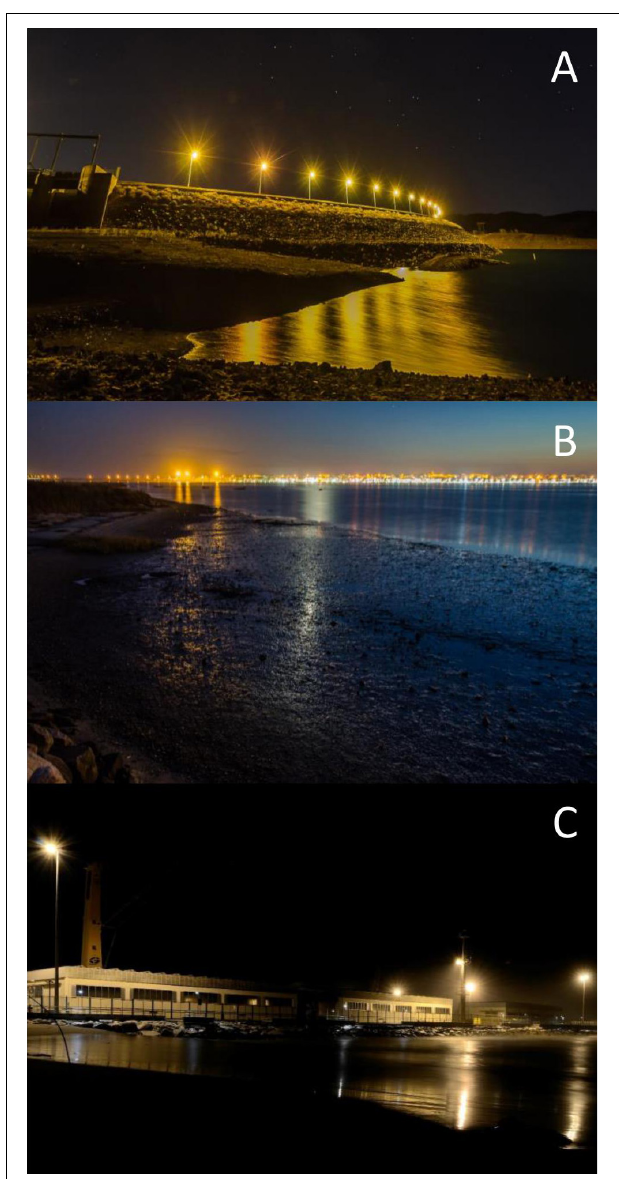
FIGURE 1 | Night light pollution caused by sources of artificial light located close (water damn, A ) or relatively far away (intertidal estuarine mudflat, B ), from water bodies and adjacent areas. (C) Example of alternating low and high intensity areas, along an artificial structure illuminated by streetlamps within a port. Photo credits: J. Serôdio (A,B) and M. Menconi (C)